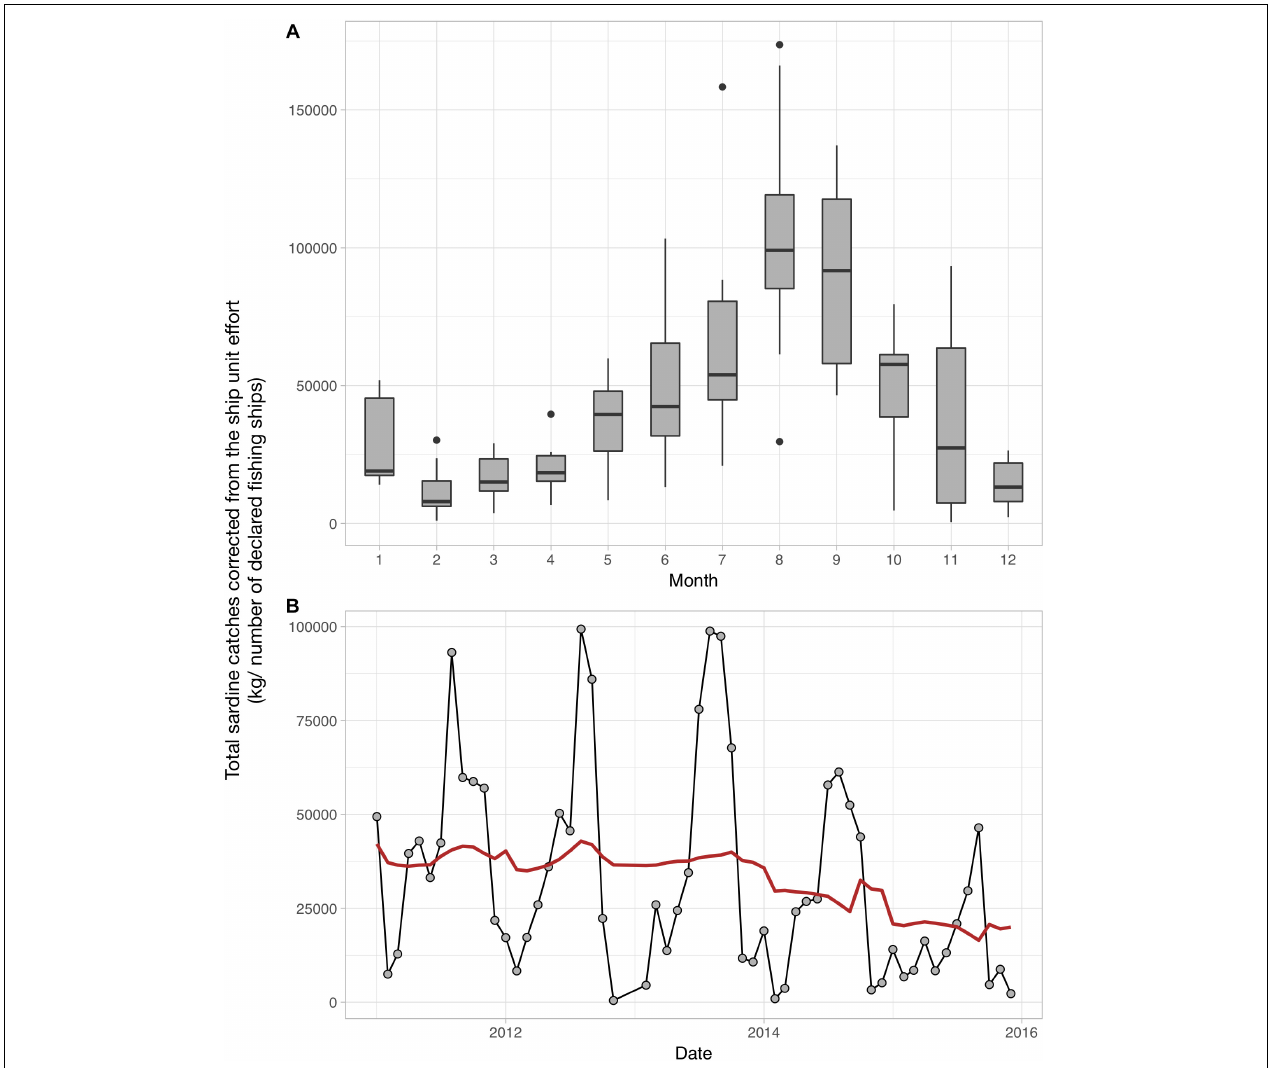
FIGURE 8 | Monthly (A) and inter-annual (B) patterns of Sardina pilchardus catches in the Iroise Sea over the 2011–2016 period. (A) The monthly distribution of S. pilchardus catches corrected by the number of fishing boats. (B) The sum of captured sardines corrected by the number of fishing boats per month over the 2011–2016 period; the red line represents the long term trend in S. pilchardus catches after removing the seasonal variability through a moving average. The sardine catches data were calculated and provided by the PNMI. These data were subsetted from the CPUEs calculated by the PNMI within the framework of fisheries indicators calculation for the “Tableaux de bord” (http://www.parc-marin-iroise.fr/Le-Parc/Objectifs/Tableau-de-bord). They are extracted from the SACROIS data associated to fishing operations carried out in the Iroise Sea, issued from the Fisheries Information System (FIS) of the “Institut Français de Recherche pour l’Exploitation de la Mer” (IFREMER) for the DPMA (Direction of fisheries and aquaculture of the French Ministry of Agriculture and Fisheries). The FIS is an operational and multidisciplinary monitoring network that enables a comprehensive view of fishery systems including their biological, technical, environmental and economical components, including small-scale fisheries. SACROIS is a validation tool for fisheries statistics, aiming to cross-check data from multiple declarative sources. The application crosses information, at the most disaggregated level, from the fishing fleet register, logbooks, monthly declarative forms (for vessels less than 10 m without logbooks, declarative forms adapted to the special features of the small-scale coastal fisheries), sales notes data, VMS data and the scientific census of fishing activity calendar.